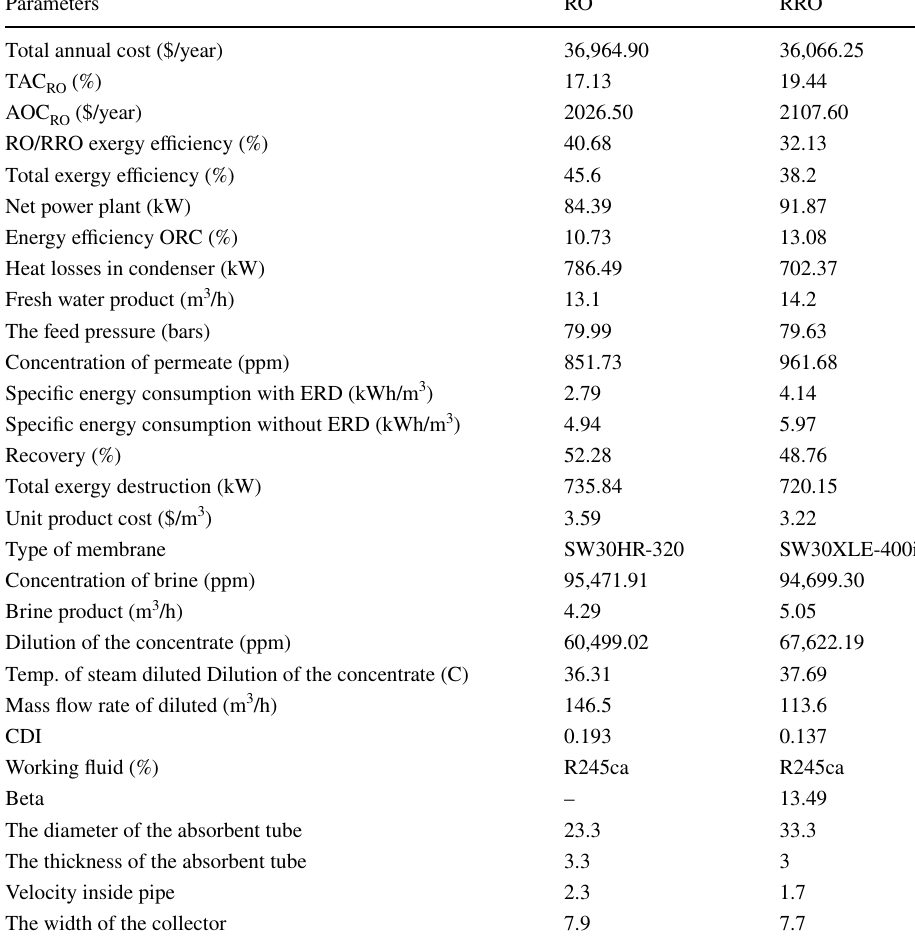
Table 9 Optimization results based on the best optimal